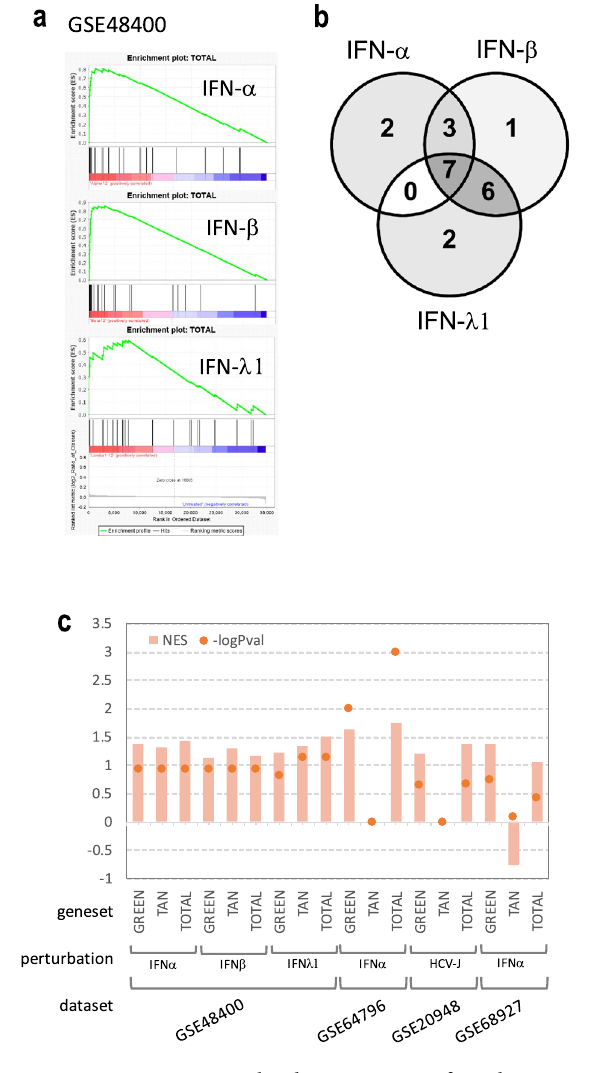
lists according to the differential expression metrics used (mainly log fold change) to compare treatments versus control samples. We then verified if our newly selected ISGs were positioned at the extremes of the gene expres- sion datasets (i.e. if they were significantly over-represented among down or up regulated genes). To do so we used the 40 unique putative mediators of interferon antiviral activity identified by our analysis as elements of three custom gene sets (Green, Tan and the combination of the two) to scan all prepared ranked datasets with the GSEA algorithm 31 . Strong upregulation of the combined geneset (genes from both the green and tan modules) was indeed observed in data obtained after induction of different interferons (Fig. 5a), even if the genes directly responsible for the observed enrichment were not always the same with a recurrent subset of 7 genes (Fig. 5b) among the annotated genes in the signature (DNPEP, REC8, GRINA, CYTH1, PCK2, NME7, SIDT1). With minimal differences due to time and method of induction, our newly selected gene signature was always detected among the up-regulated genes after induction or interferon related perturbation: in all analyzed published data- sets taken into account the custom Green, Tan and total genesets showed a significant enrichment in most cases, with the Tan geneset being the weakest with a p -Value below the cutoff in three out of four datasets and the combined geneset just below the cutoff in GSE68927 data (Fig. 5c). Individual GSEA enrichment plots are shown